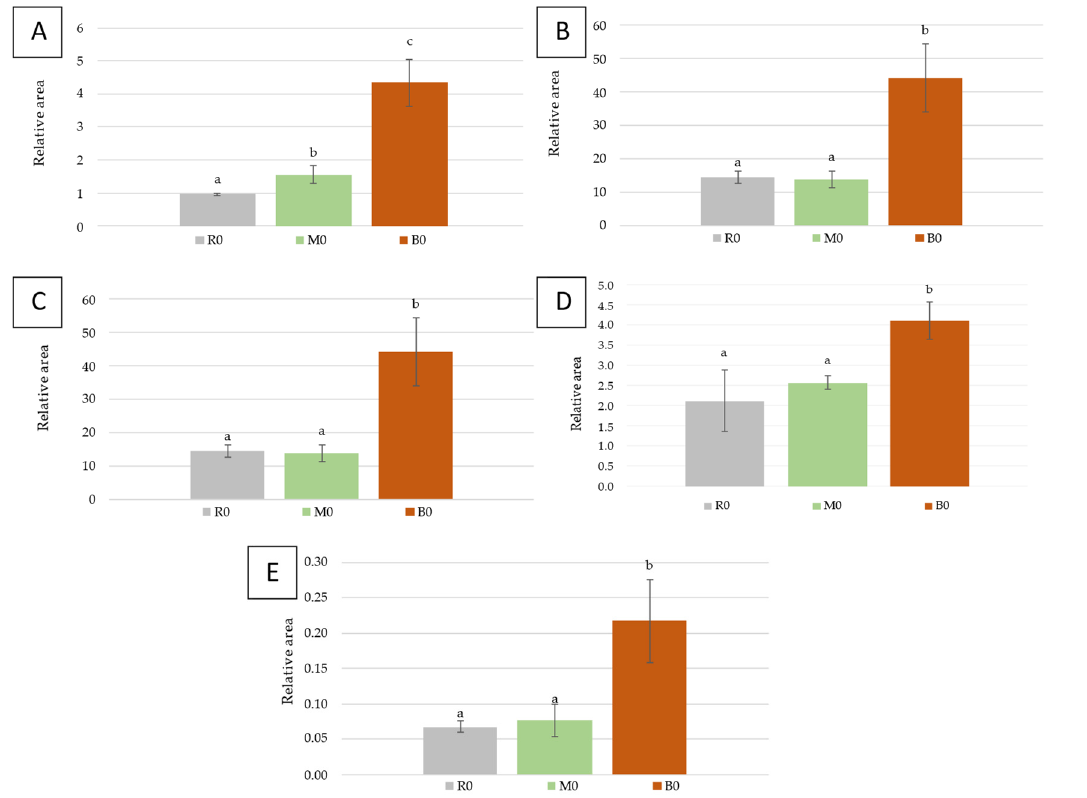
Figure 2. Contents found in wines produced without a prefermentative maceration ( n = 6).